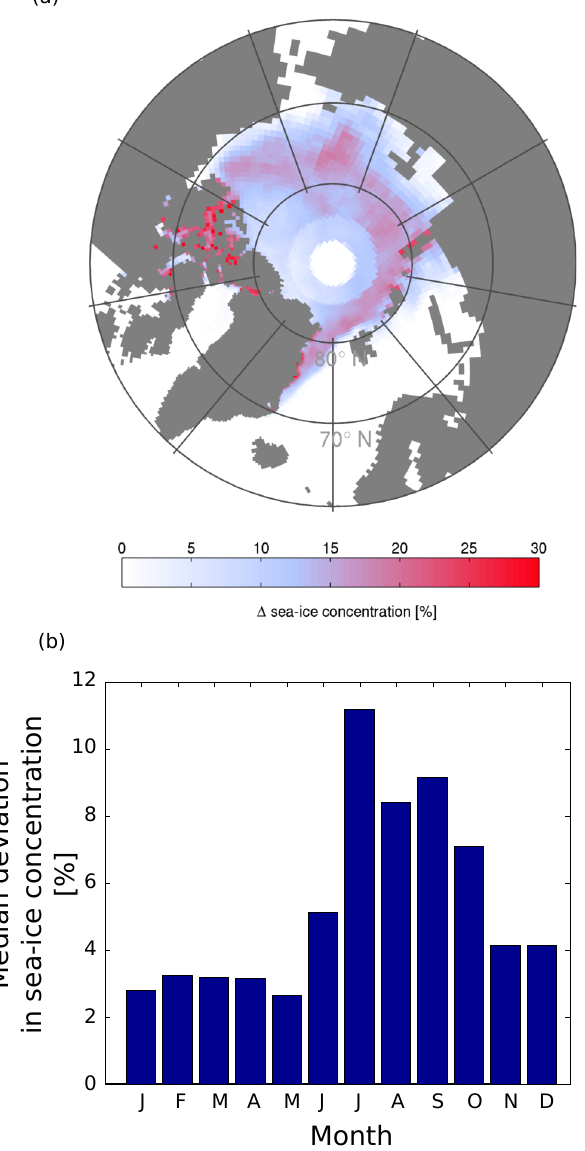
Fig. 13. (a) Mean difference in September sea-ice concentration be- tween Bootstrap retrieval and NASA Team retrieval for the period 1979–2007 (Bootstrap minus NASA Team). (b) Monthly median deviation in sea-ice concentration between Bootstrap retrieval and NASA Team retrieval for the period